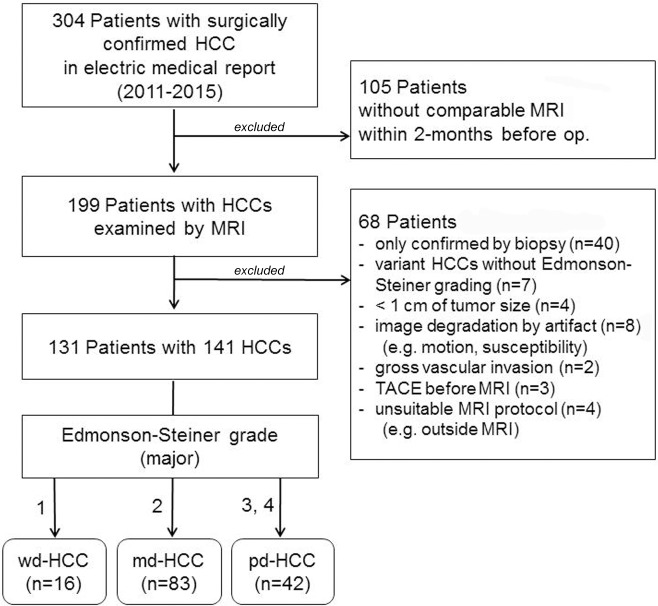
Flowchart of patient selection.HCC, hepatocellular carcinoma; wd, well-differentiated; md, moderately-differentiated; pd, poorly-differentiated; TACE, transcatheter arterial chemoembolization.